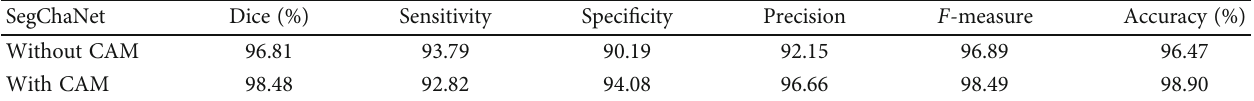
Table 7: SegChaNet method with/out CAM